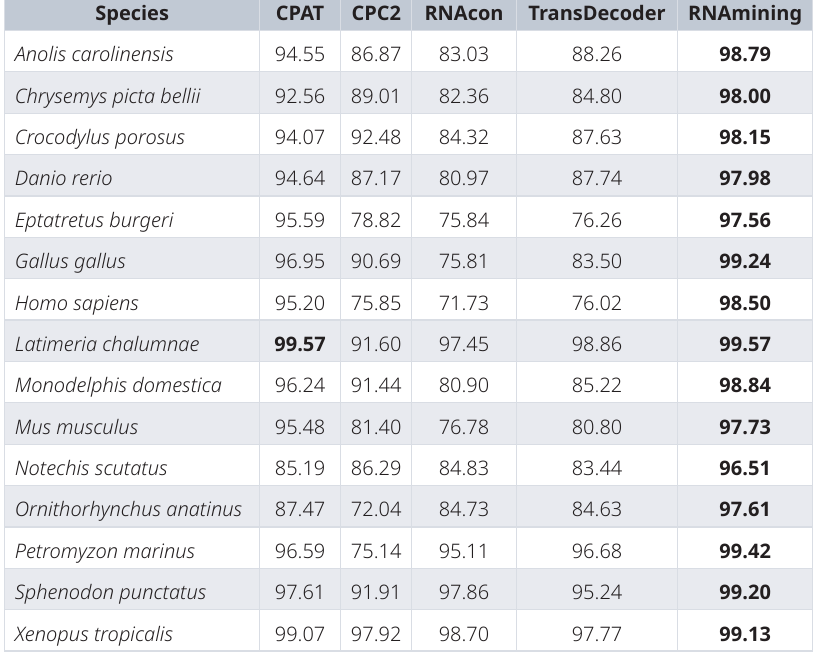
Table 5. Benchmarking results from RNAmining and the other tools already described in the literature according to organisms from different evolutionary branches. F1-score metric for CPAT, CPC2, RNAcon, TransDecorder and RNAmining, based on the predictions using models provided by each tool or generated according to their instructions. The bold numbers are the best values regarding F1-score metric. The results for other metrics were made available at the Extended data: Supplementary File S2 19